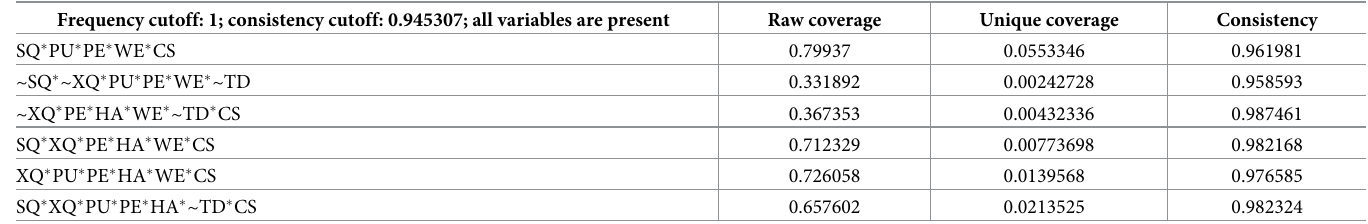
Table 7. Intermediate solution. Frequency cutoff: 1; consistency cutoff: 0.945307; all variables are present